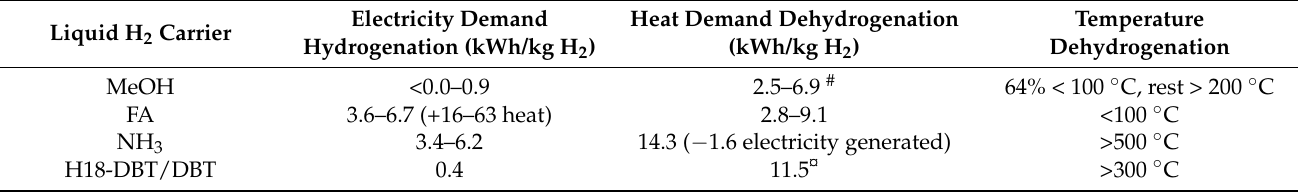
Table 2. Electricity and heat demands of dehydrogenation and hydrogenation